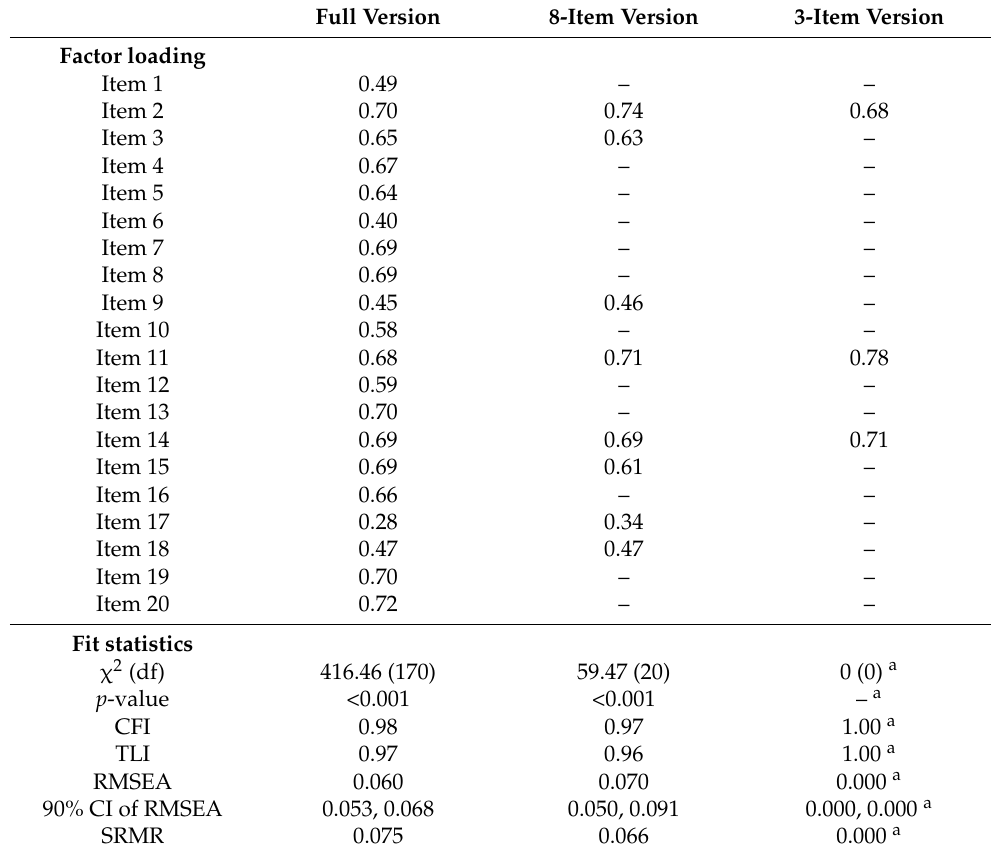
Table 3. Confirmatory factor analysis results of the UCLA Loneliness Scale (Version 3) and its short versions (N = 400).